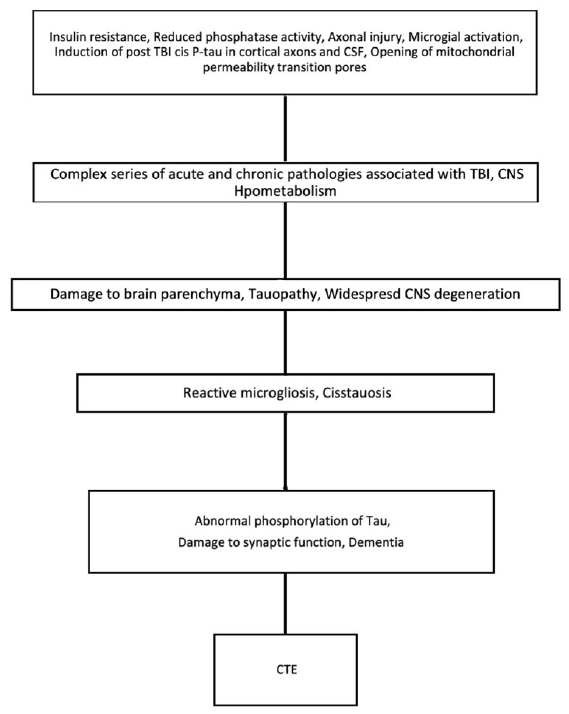
Figure 3. Key events which cause the progression of TBI to